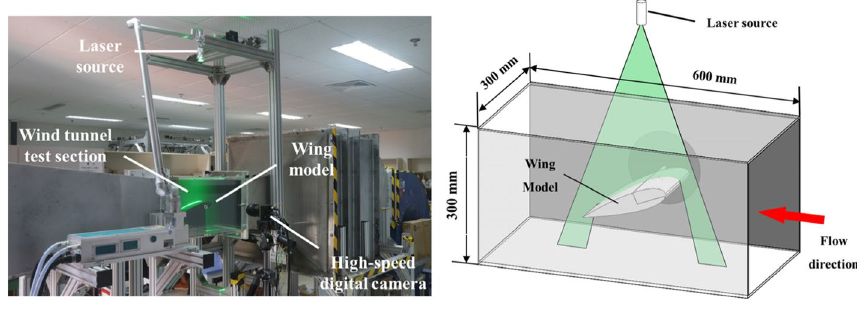
Fig. 3 Wind tunnel experimental system